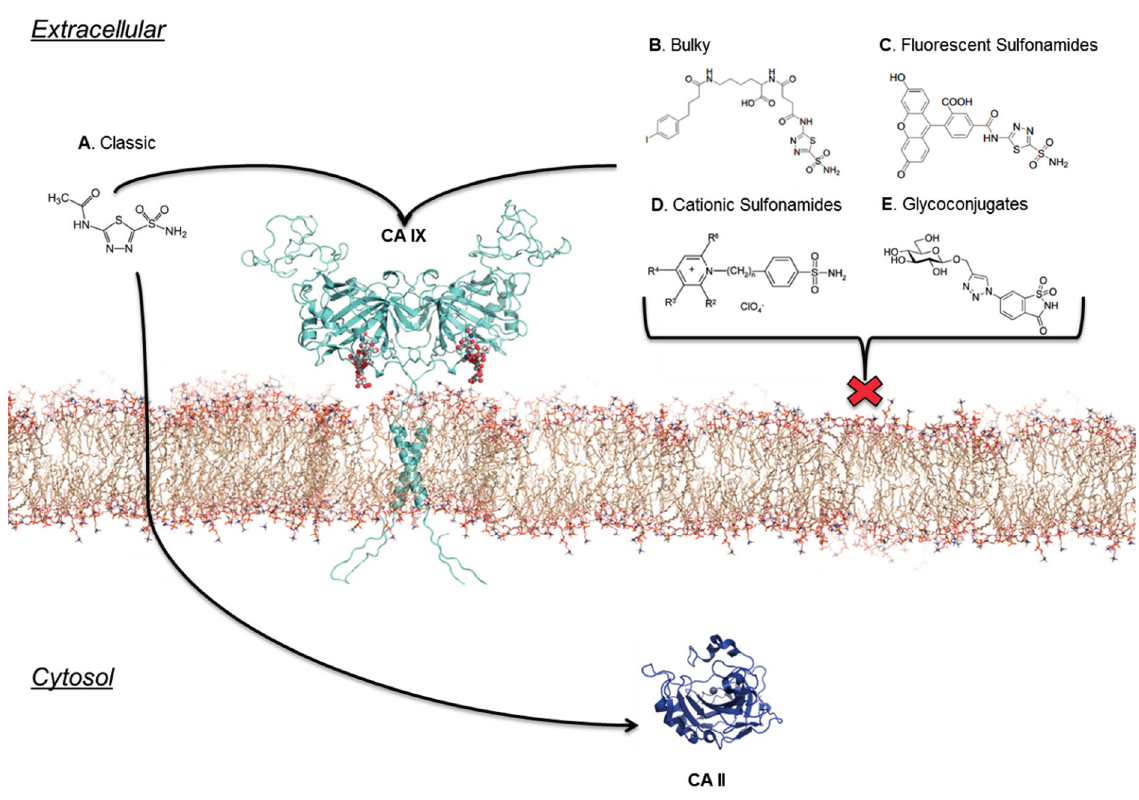
Figure 5. CAIs designed to target the extracellular CA domain of CA IX as compared to classic inhibitors. ( A ) Classic ( B ) Bulky ( C ) Fluorescent ( D ) Cationic sulfonamides ( E ) Glycoconjugates all show extensive differences in terms of CA IX specific targeting potential. (Figure was adapted from [67] and made using PyMol [28] and ChemDraw [68] software